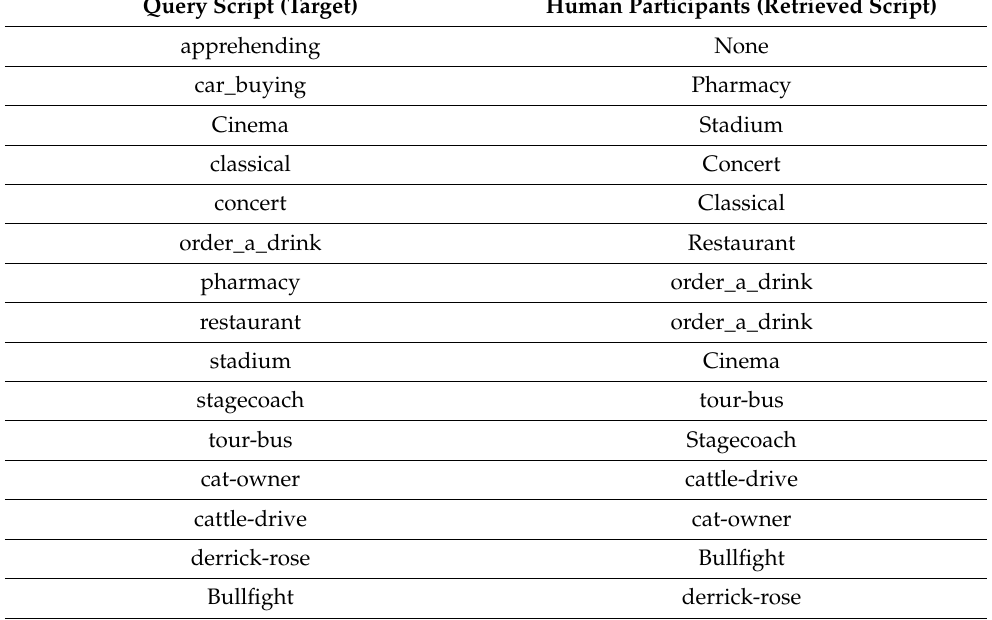
Table 3. Most similar scripts from human perspective.